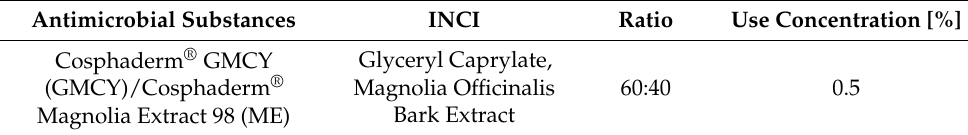
Table 2. Composition and use concentration of the antimicrobial agents.